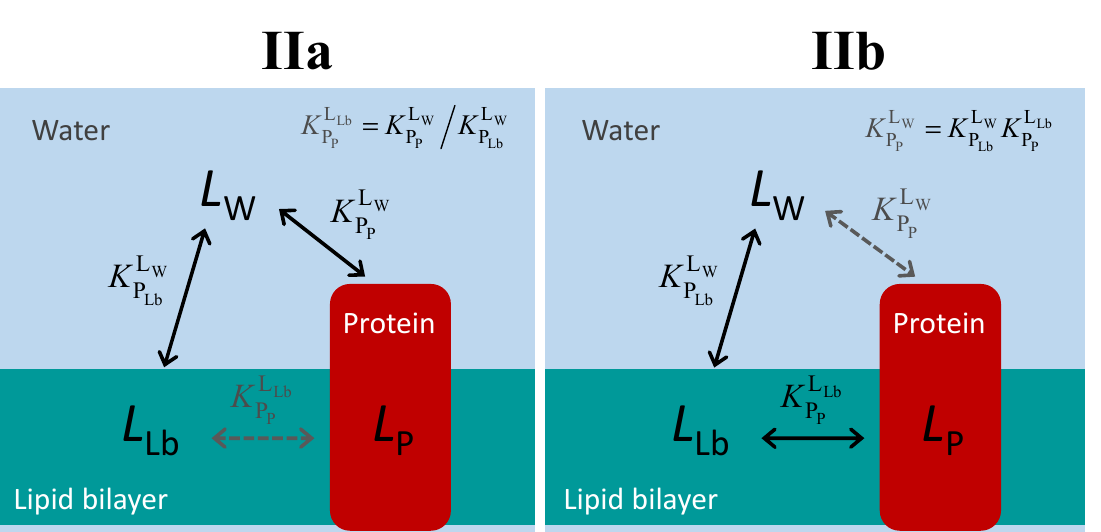
Figure 4. Schematic representation of the ligand equilibrium distribution between the lipid bilayer and a membrane protein for the case of ligand-protein binding from the aqueous medium ( IIa ) or from the lipid bilayer ( IIb ). The equilibria indicated in black correspond to paths that may be followed by the ligand, while the equilibrium in grey results only from the impositions of the thermodynamic cycle.